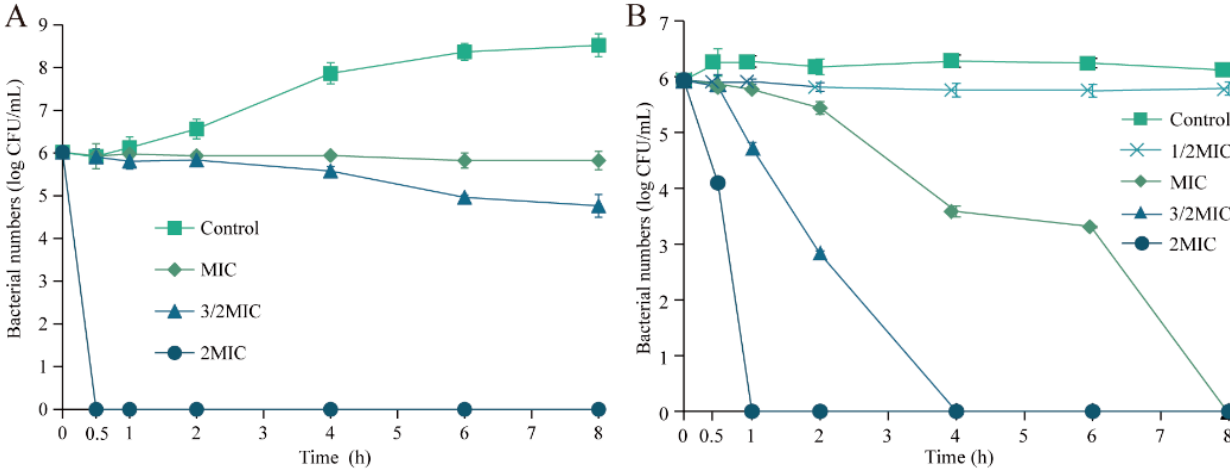
Figure 3. Inactivation effect of eugenol on Sh. flexneri in the LB broth ( A ) and PBS ( B ). 3.4. The Bactericidal Effect of Eugenol on Food Easily Contaminated by Sh. flexneri 3.4.1. Inactivation Effect of Eugenol on Sh. flexneri in Vegetable